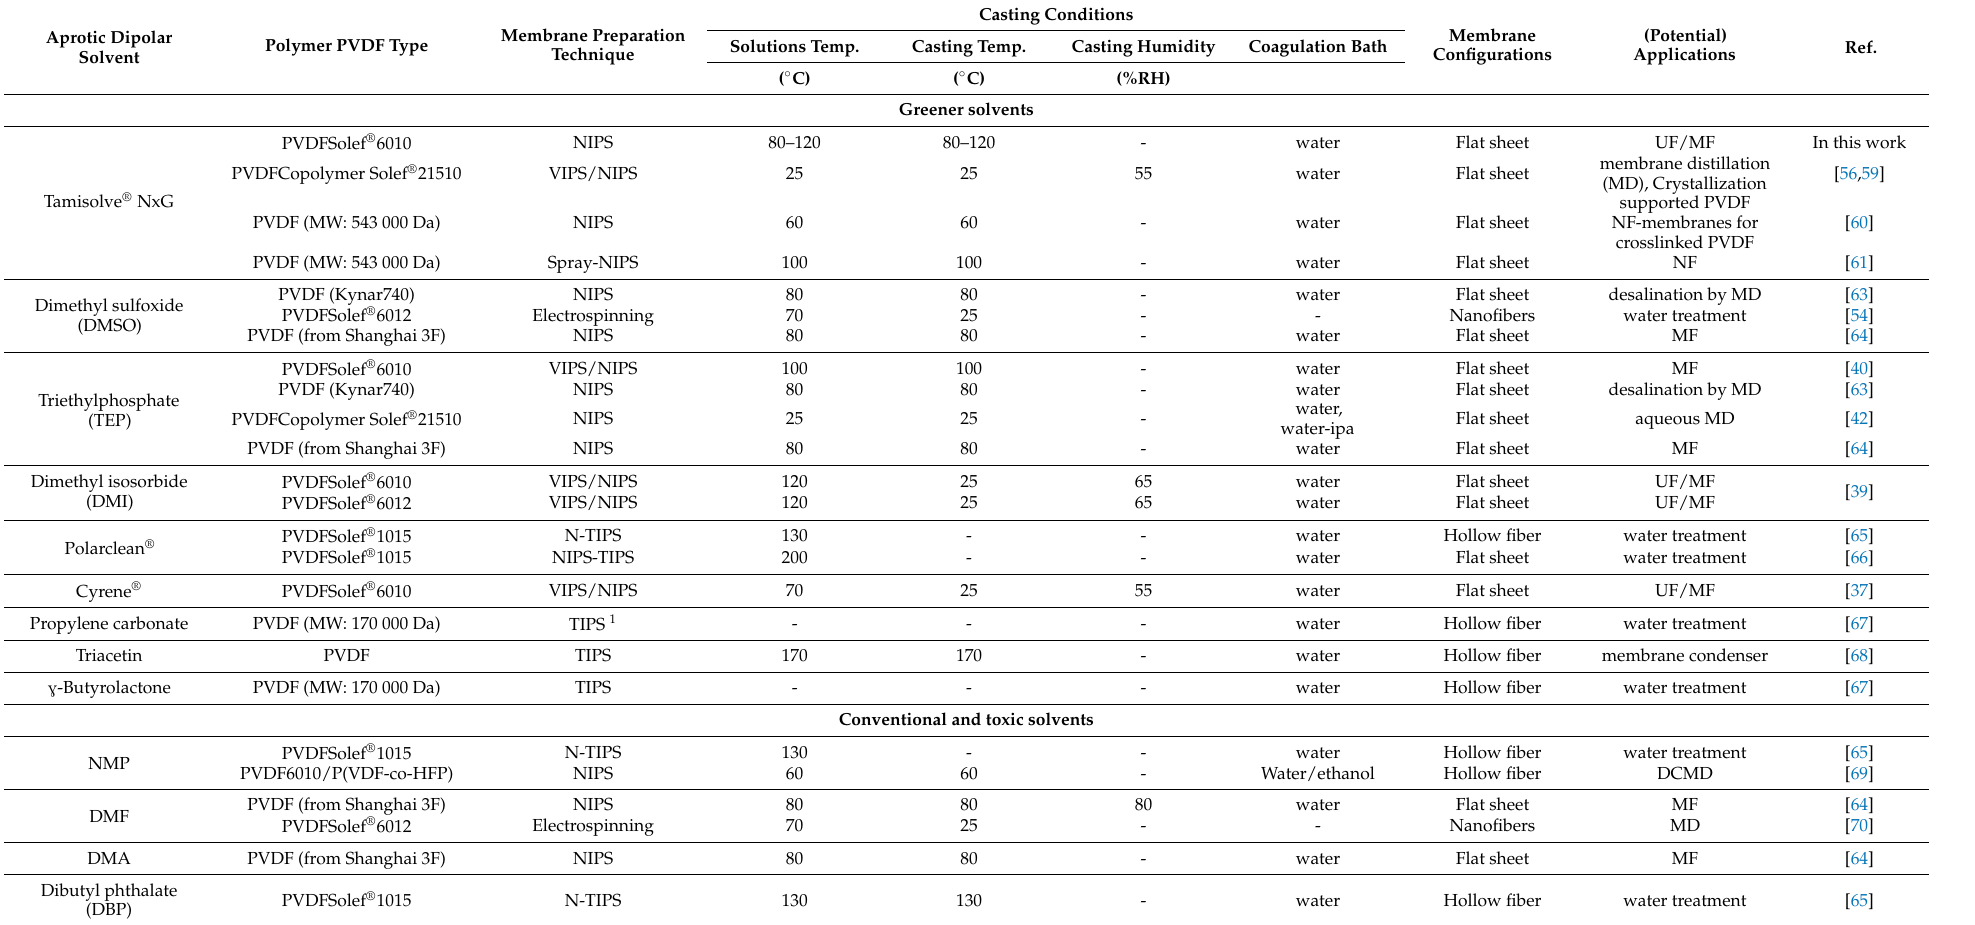
Table 1. Greener and conventional toxic aprotic solvents for the preparation of PVDF